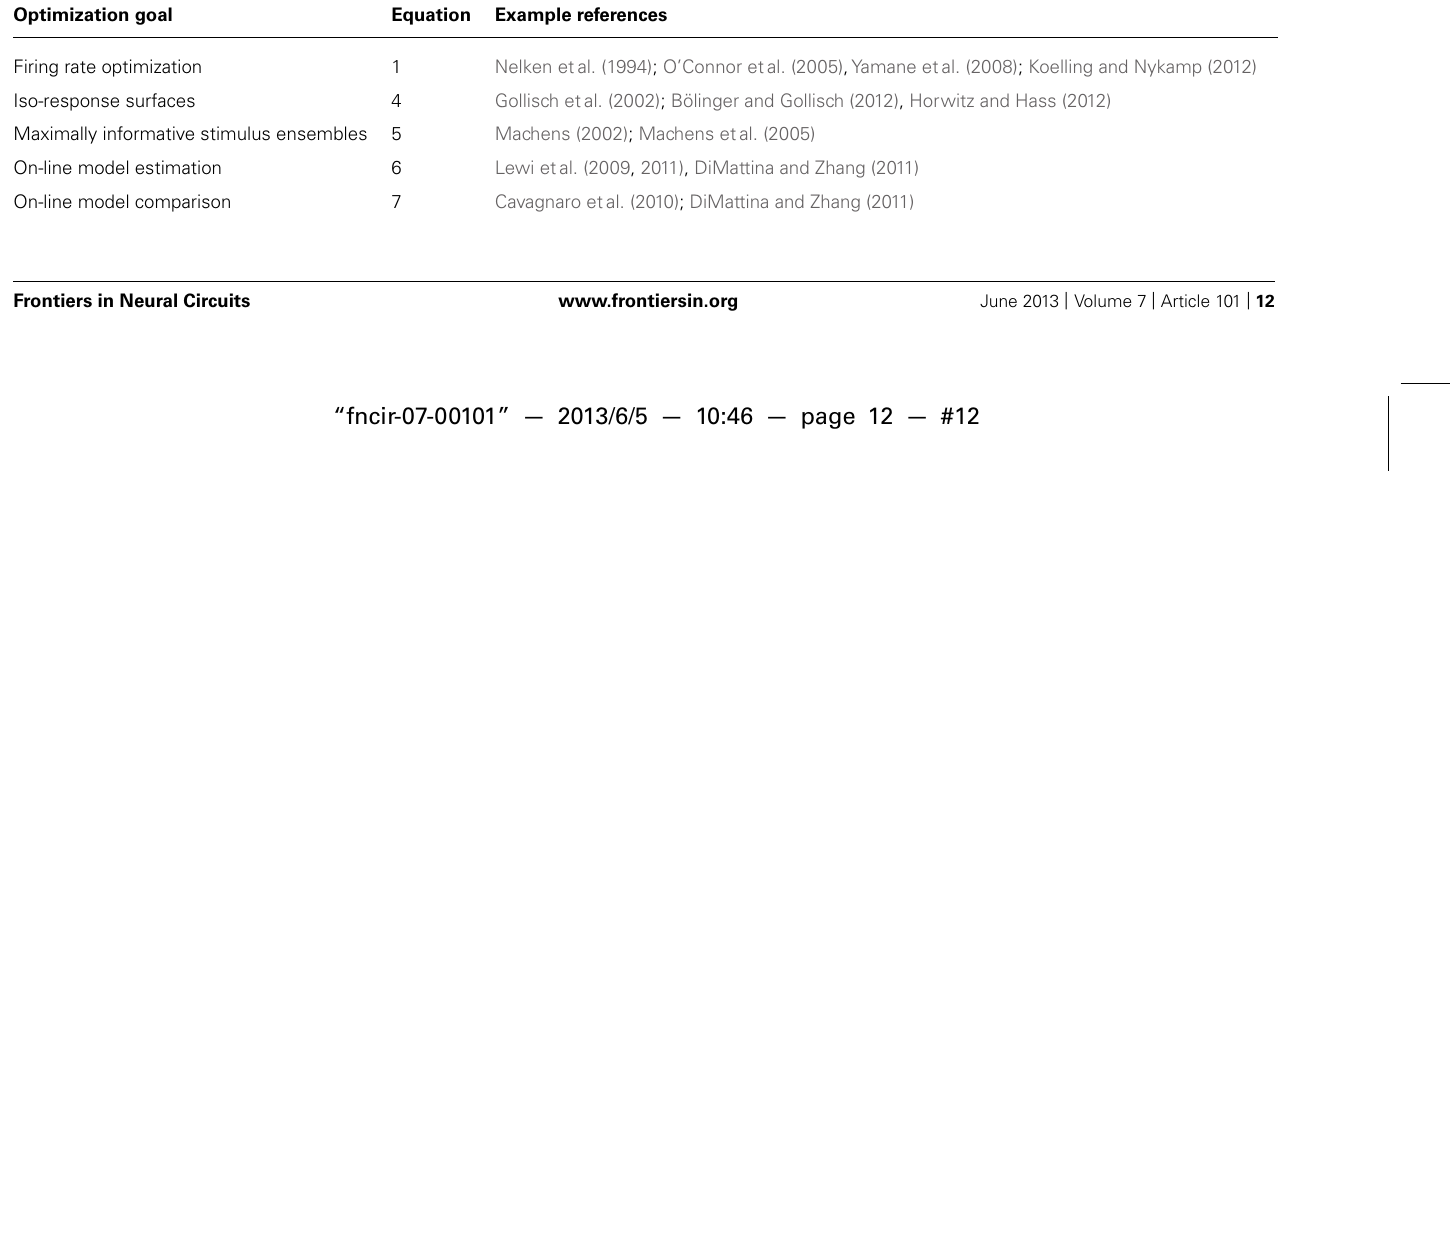
Table 1 | Summary of various closed-loop stimulus optimization approaches utilized in sensory systems neuroscience. Optimization